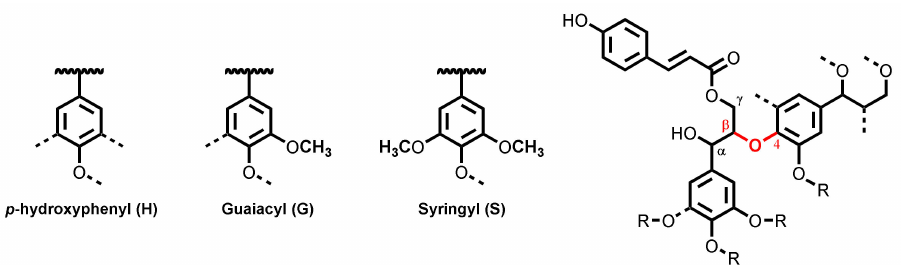
Figure 1. Lignin monomers with potential branchpoints marked with a dashed line; a structure of a possible lignin fragment containing the β -O-4 aryl ether